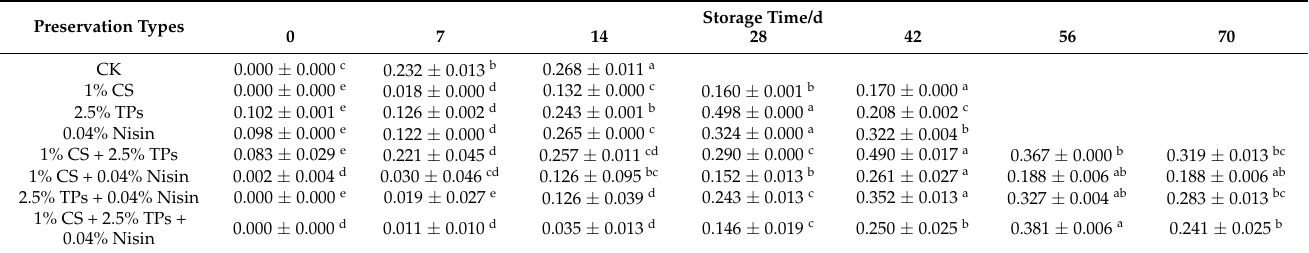
Table 3. Effects of compound preservatives on TBARS of plant-based meat.